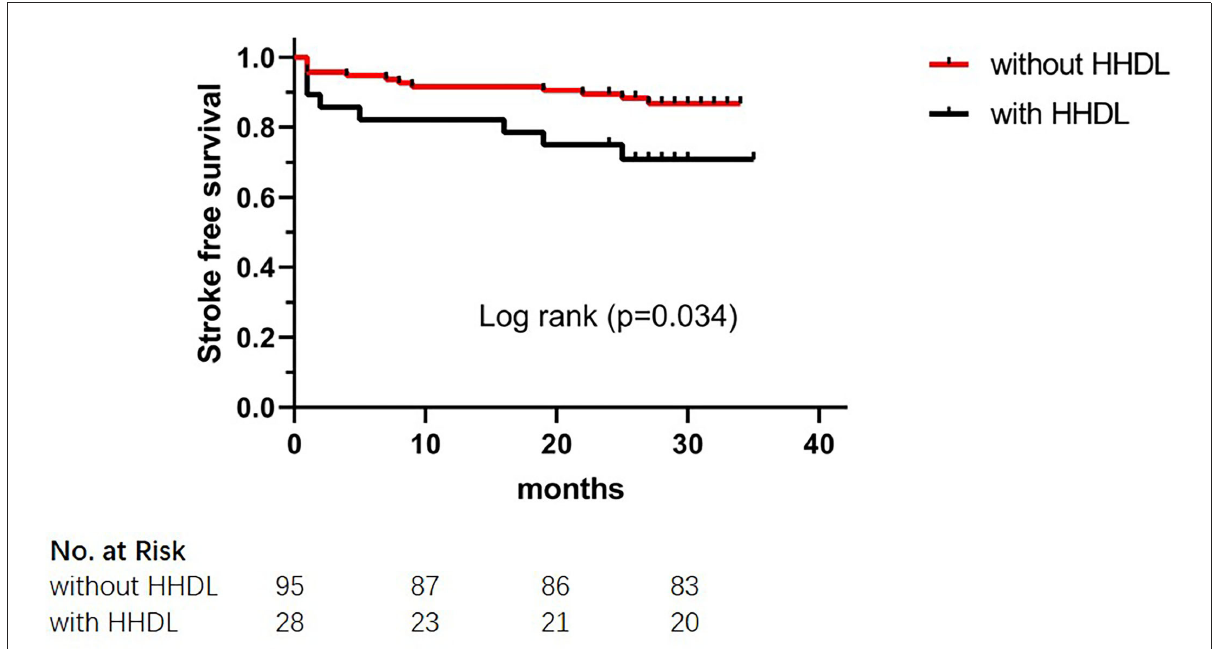
FIGURE1 The Kaplan–Meier cumulative hazard curve for stroke recurrence comparing participants with HHDL and participants without HHDL.